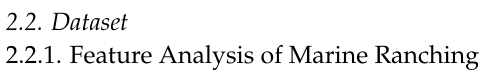
Table 2. Experimental data of GF-1.